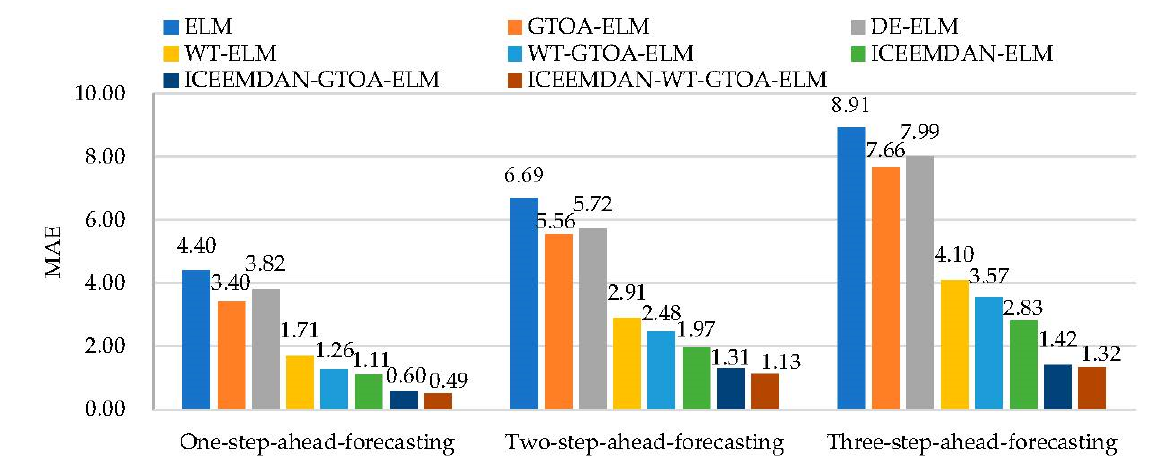
Figure 9. MAE of PM2.5 forecasting.